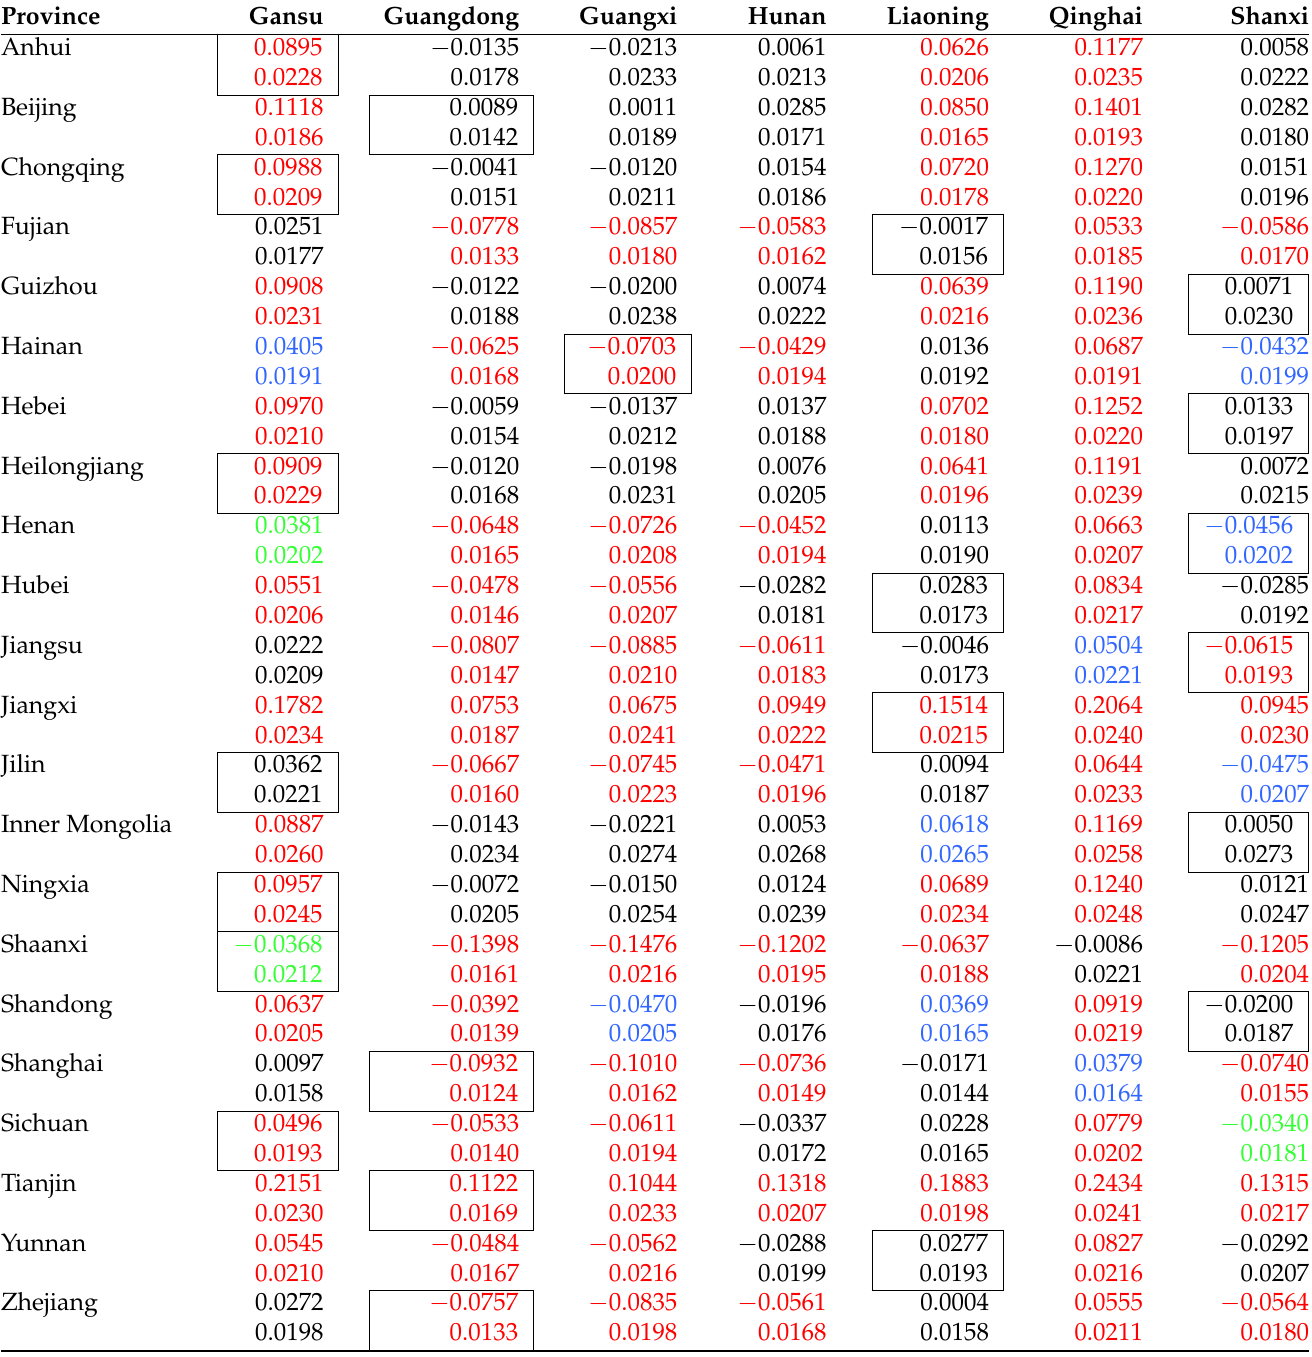
Table 7. ATET estimates (with corresponding standard error listed beneath) for each treated (row) vs. each control (column) province (for all families) for the presence of a bank account: Significance of point estimates at the arbitrary 1, 5, and 10 percent levels are colored red, blue, and green, respectively—a box is given for the control province most closely aligned with the treatment province in terms of absolute minimum